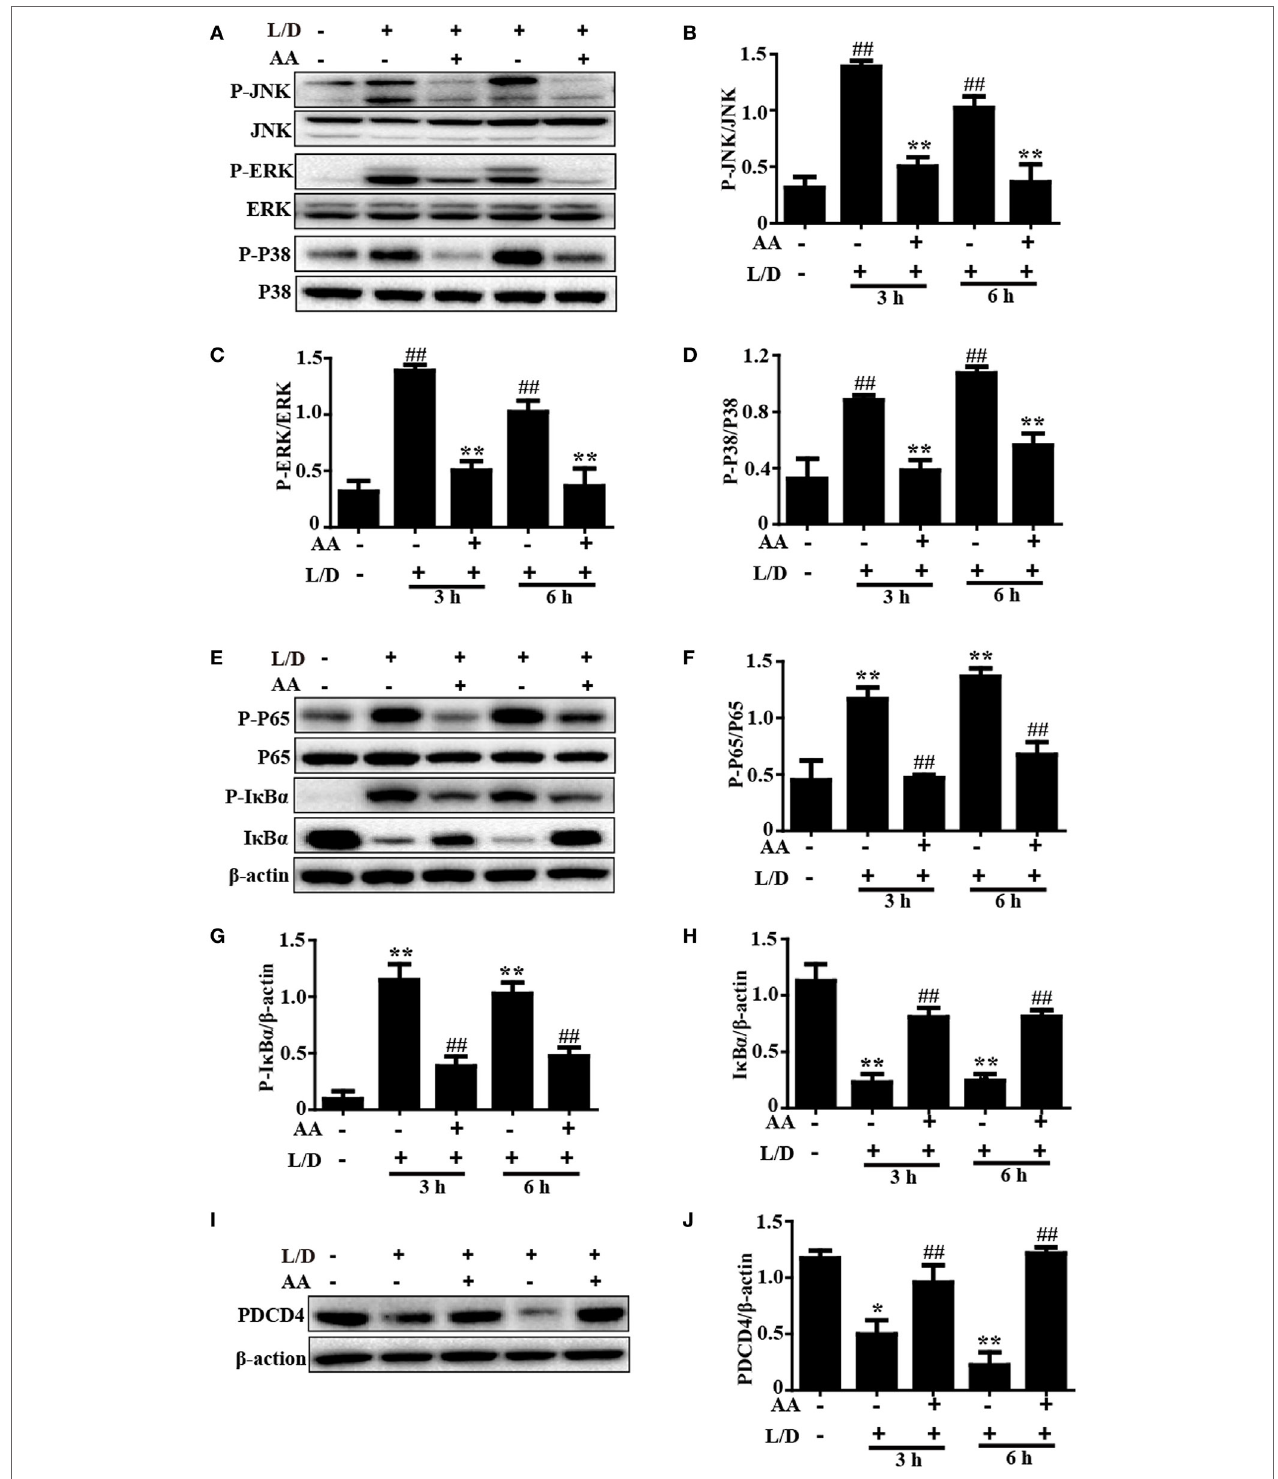
FigUre 3 | Inhibitory effects of asiatic acid (AA) treatment on NF- κ B, mitogen-activated protein kinase, and PDCD4 in L/D-induced fulminant hepatic failure. Liver tissues were collected from the mice 3 or 6 h after L/D challenge and analyzed by Western blotting. (a,e,i) Effects of AA on P-JNK, P-extracellular signal-regulated kinase (ERK), P-P38, P-P65, P-I κ B α , I κ B α , and PDCD4 expression were measured by Western blotting. (B–D,F–h,J) Quantification of relative protein expression was performed by densitometric analysis. Similar results were obtained from three independent experiments. All data are presented as means ± SEM ( n = 5 in each group). * p < 0.05 and ** p < 0.01 vs. control group; # p < 0.05 and ## p < 0.01 vs. L/D